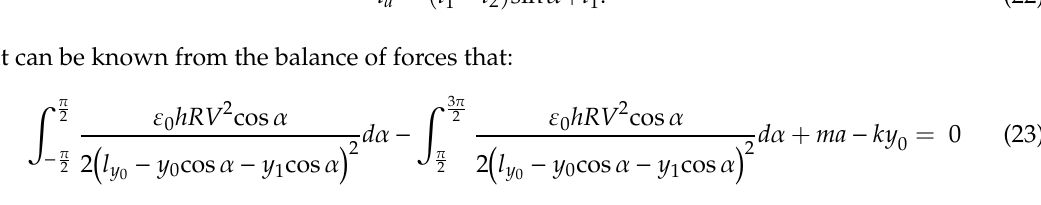
Figure 9. Schematic diagram of the force model of an elastomer body.